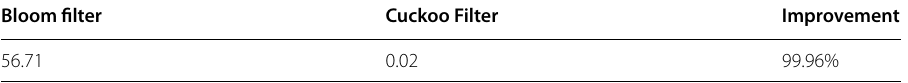
Table 1 Experimental results 1: lookup performance after deletion. Query execution time in milliseconds